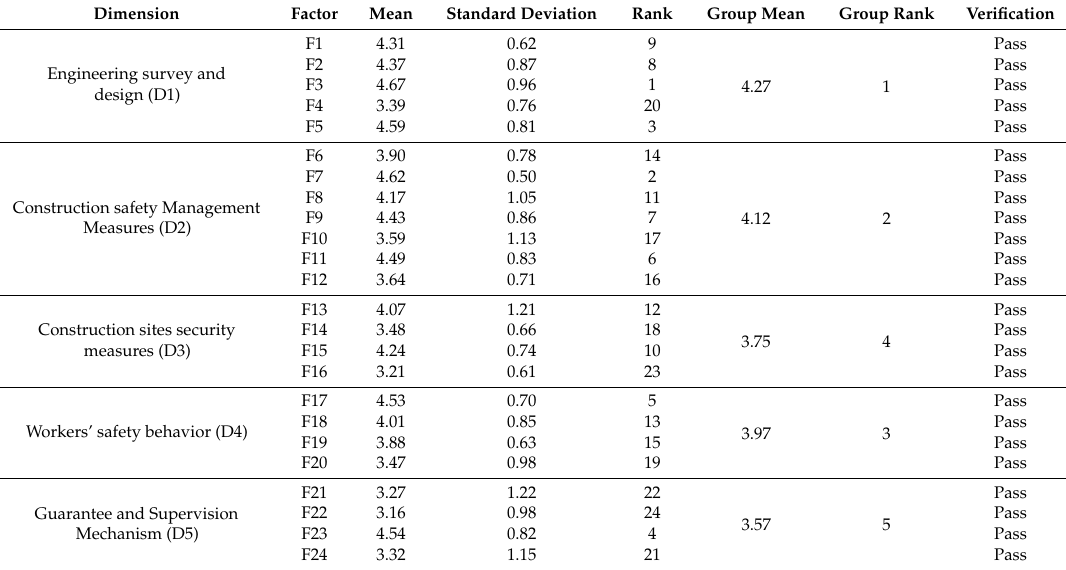
Table 4. Scores and ranking of the